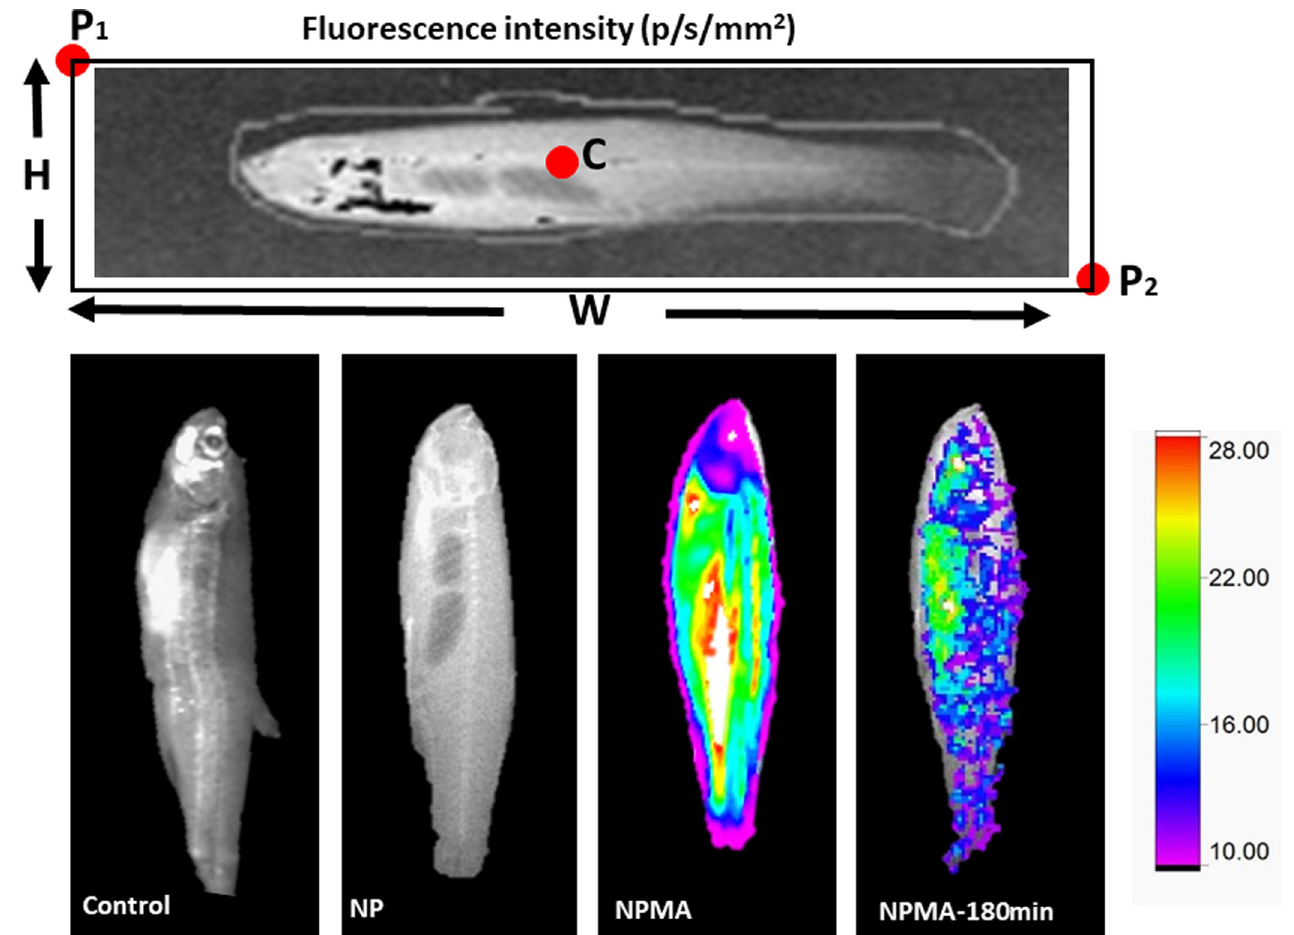
Fig 5. Interaction between mucoadhesive nanocapsules and zebrafish. In vivo fluorescence images of zebrafish exposes to NPMAs.